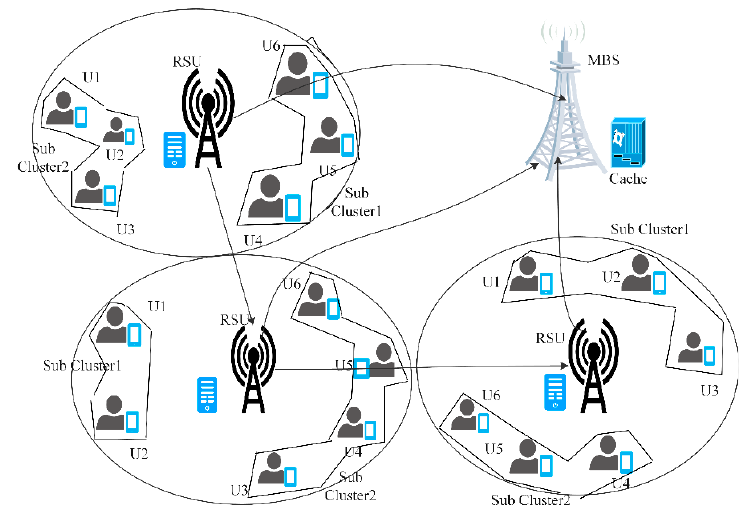
Figure 4. COOP using K-means clustering .